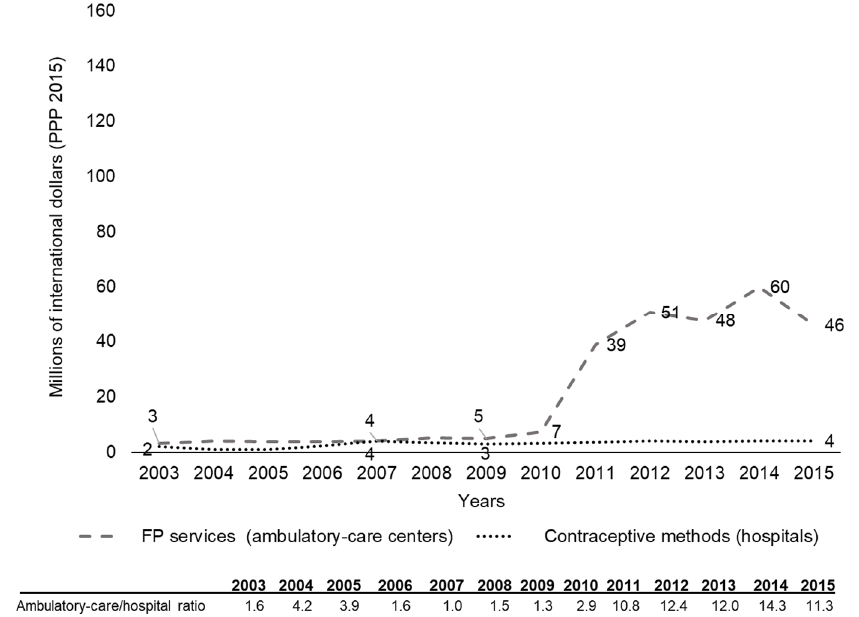
Figure 3. Government Family Planning (FP) expenditure for the entire adolescent population aged 10–19 without Social Security coverage, by type of healthcare provider, Mexico, 2003–2015, $ million (PPP 2015).